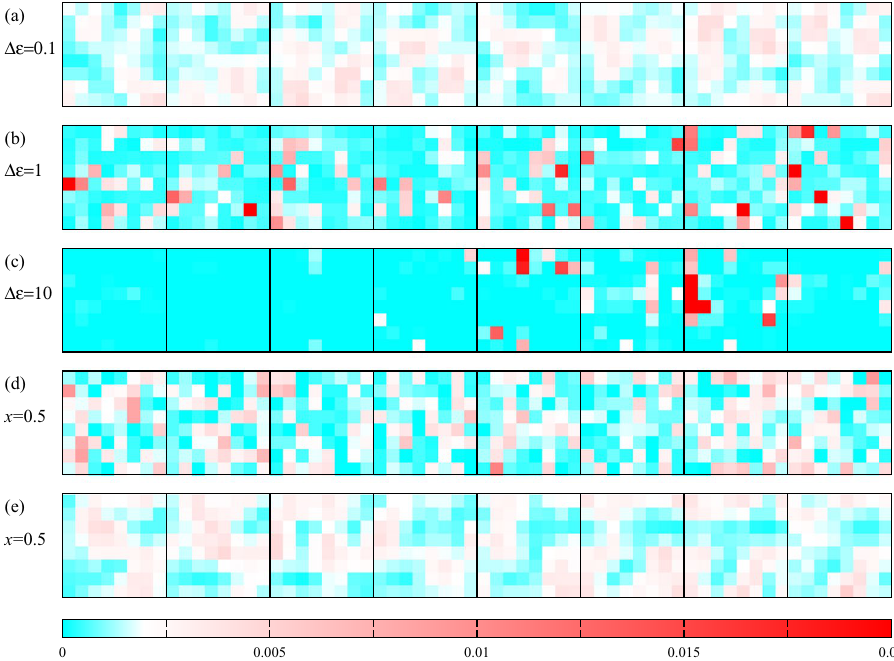
Figure 3. Probability distribution for different disorder settings for the state with index n = 12, 312 which lies inside the valence band 1.66 eV below the VBM. Each panel has eight squares that correspond to the eight layers of unit cells in our 8 × 8 × 8 supercell. Each one of the eight squares is divided into 8 × 8 small squares that correspond to the 8 × 8 unit cells in that layer. In other words, each panel has 512 small squares with different colours, representing the occupation probabilities of the 512 unit cells in our simulated supercell. A white square corresponds to a probability 1/512 (meaning that a uniform probability distribution would give an all- white figure), while blue corresponds to lower probabilities and red corresponds to higher probabilities (such that strong colours, especially with a mostly blue background and a few red squares, imply strongly localized states). Panels (a–c) correspond to on-site disorder with for the wavefunction to localize with increasing ∆  is clear from these panels. Panels (d) and (e) show the probability distribution for disorder originating from halide mixing. Here we assume disorder in the hopping strengths, and we take a 50-50 mixture of I and Br. In Panel (d) we show the results for the model where the Br orbital energies are different from those of I, while in Panel (e) we show the results for the model where the hopping strength between Pb and Br is different from that between Pb and